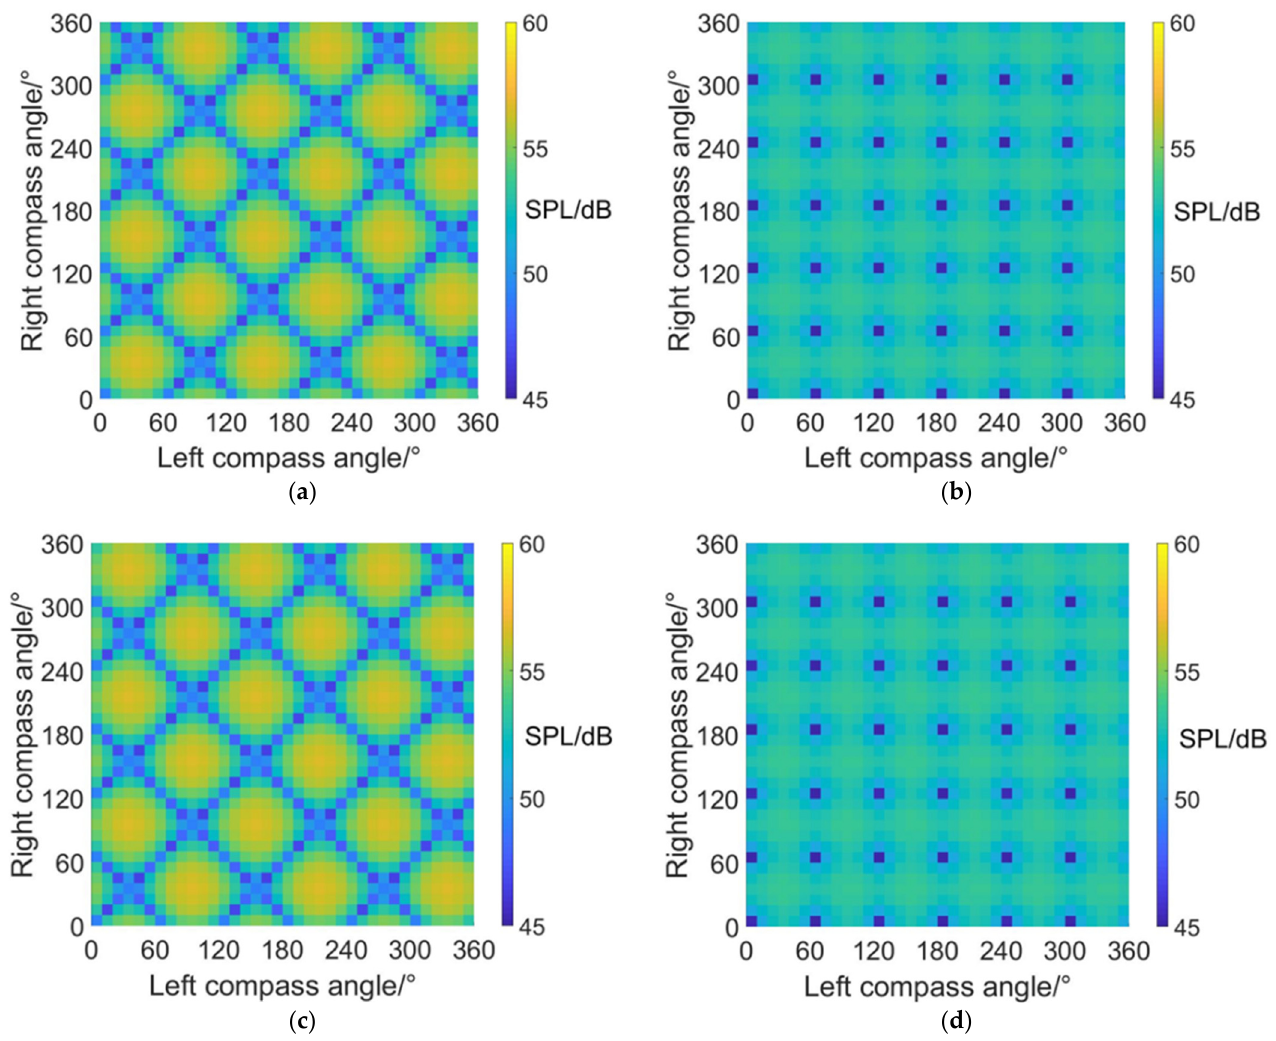
Figure 10. Carpet diagrams of noise SPL in helicopter mode at an azimuth angle = 0 ◦ with the scissors angle difference = ( a ) 0 ◦ , ( b ) 30 ◦ , ( c ) 60 ◦ , ( d ) 90 ◦ . With scissors angle difference = 30° or 90°, noise SPL reaches relatively low values The highest SPL and range of relatively low SPL values at an azimuth angle = 0 ◦ in helicopter mode are listed in Table 5, indicating that the noise SPL at an azimuth angle = 0 ◦ (forehead) can be reduced by 7.4~10.4 dB after CSM phase modulation. Table 5. Maximum and minimum SPL values at an azimuth angle = 0 ◦ in helicopter mode. Scissors Angle Difference/